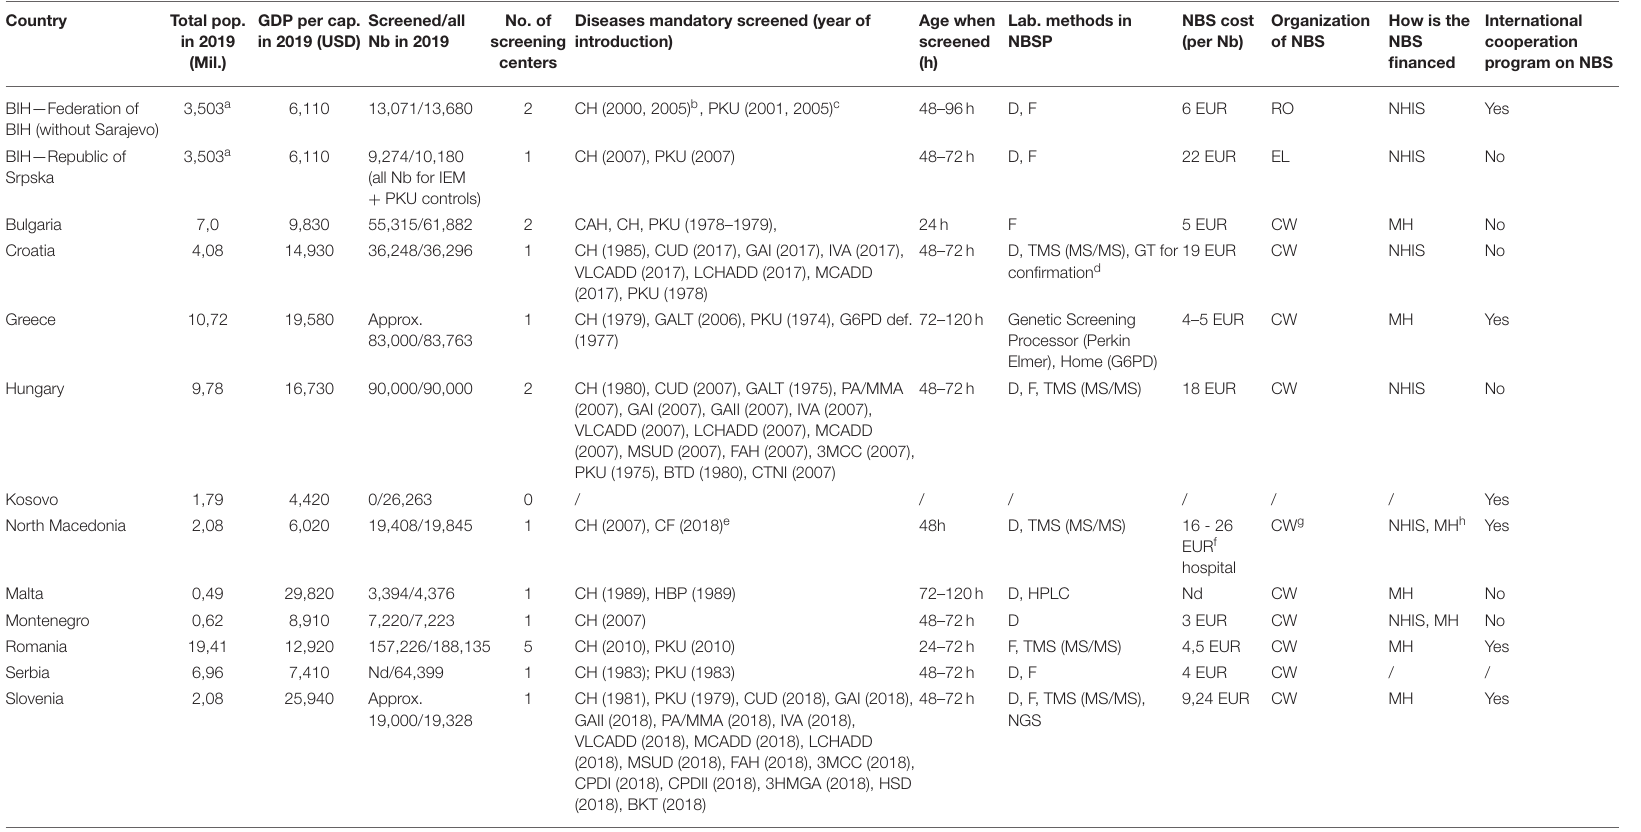
TABLE 1 | Demographics and newborn screening programs characteristics in southeastern Europe. Country Total pop. GDP per cap. Screened/all in 2019 in 2019 (USD) Nb in (Mil.)